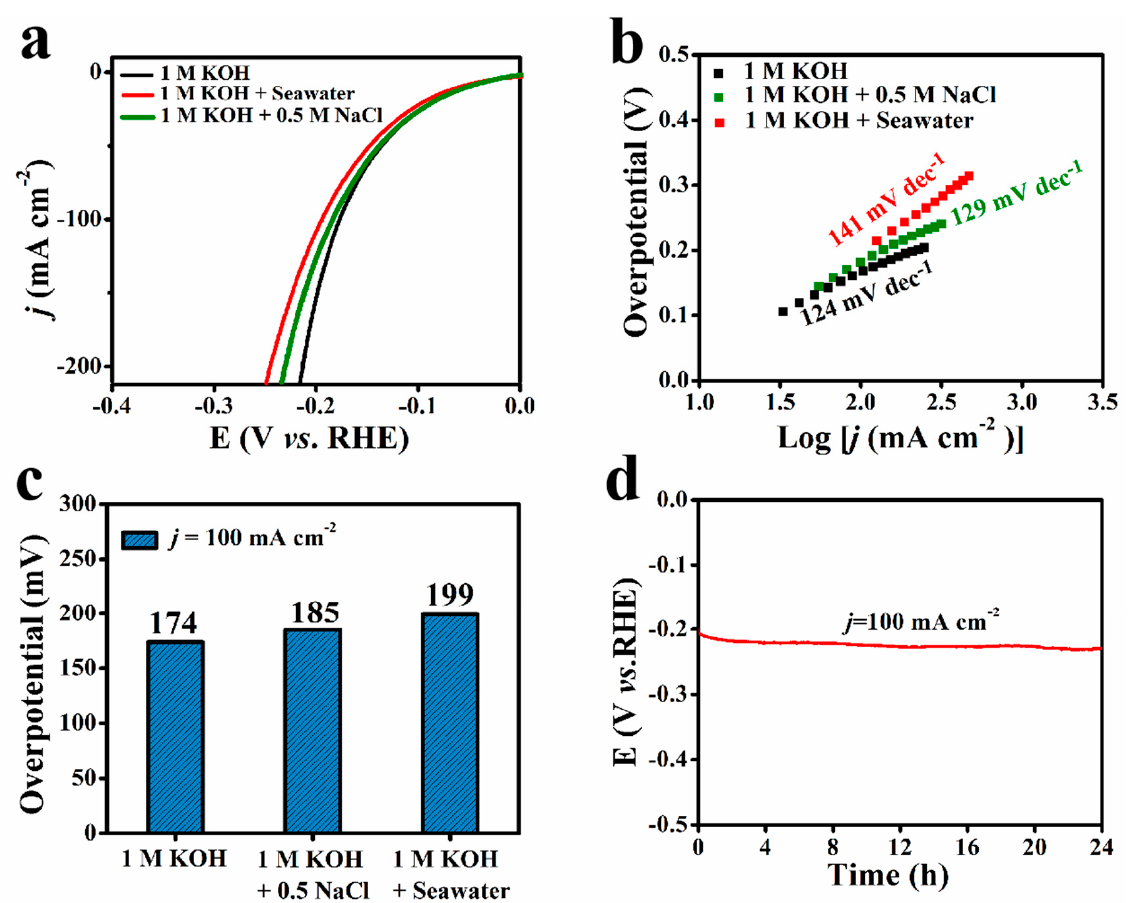
Figure 4. ( a ) Polarization curves of Co-Mo-B/NF in different electrolytes. ( b ) Overpotentials at 100 mA cm –2 for Co-Mo-B/NF in different electrolytes. ( c ) Tafel plots of Co-Mo-B/NF in different electrolytes. ( d ) Durability test of Co-Mo-B/NF in 1 M KOH + seawater.